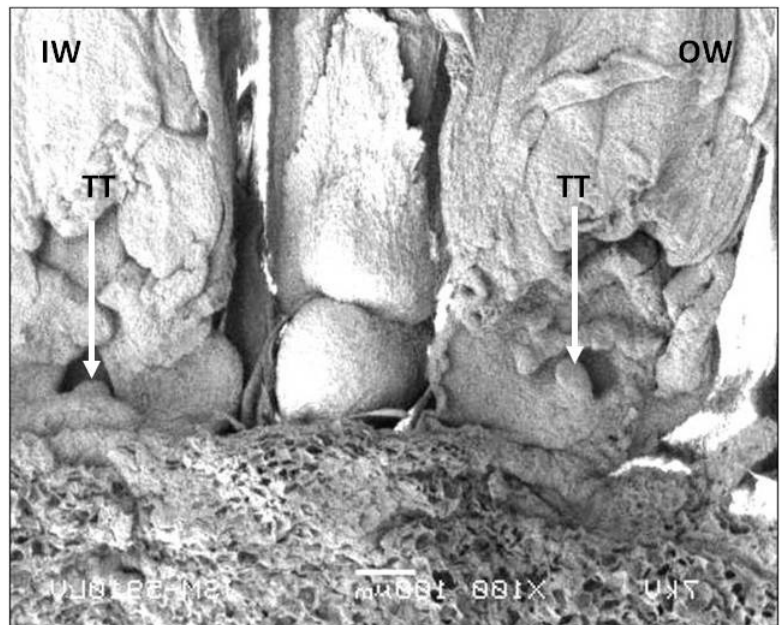
Fig. 10. SEM analysis of ovules in the florets located side by side in capitulum of H. annuus . OW: Outer whorl floret, IW: Inner whorl floret, O: Ovule